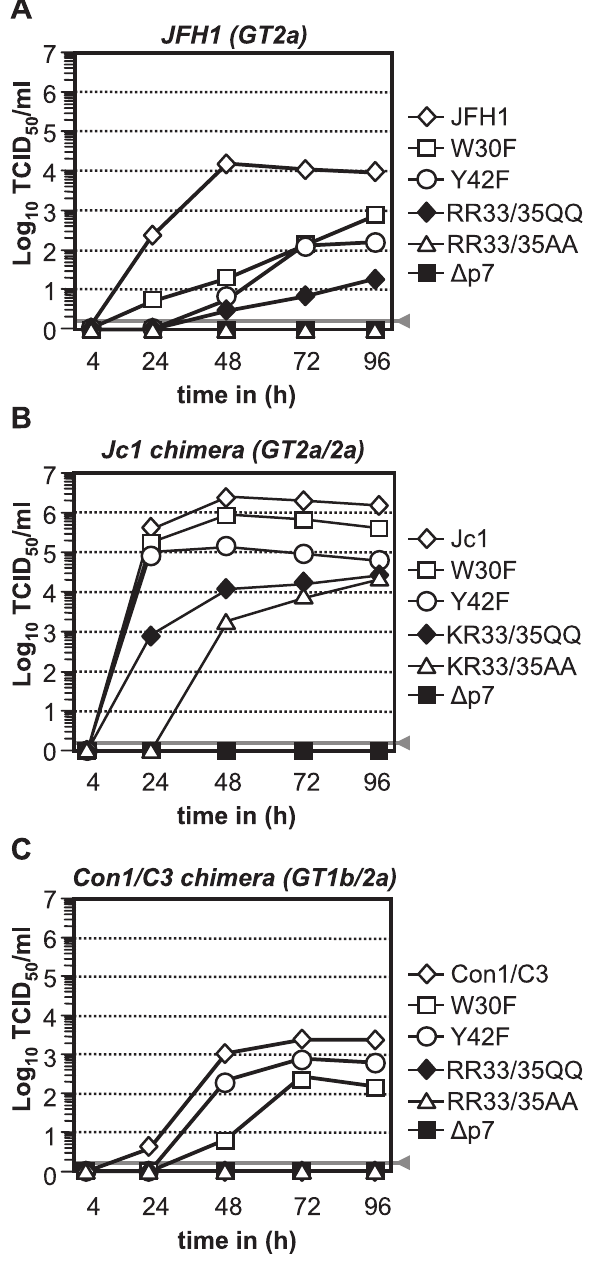
Figure 3. Accumulation of Infectivity upon Transfection of JFH1 or Chimeras Carrying Varying p7 Mutations Huh-7.5 cells were transfected with (A) JFH1, (B) Jc1, or (C) Con1/C3 wild- type constructs or given p7 mutants in the context of the respective virus. Cell-free supernatants were harvested and titrated by using a limiting dilution assay. The gray bars represent the detection limit of the limiting dilution assay.